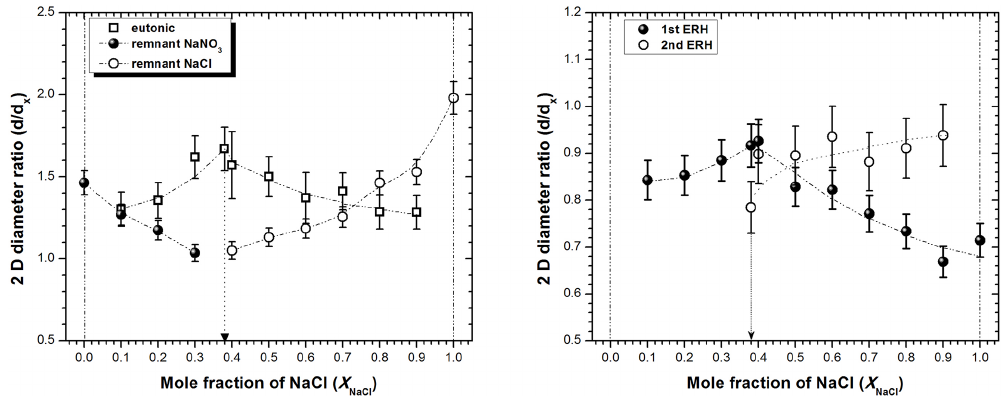
Figure 6. (a) 2-D diameter ratios ( d/d x ) of the particles/aerosols plotted as a function of the NaCl mole fractions ( X NaCl ) , which represent the size increase due to the mutual deliquescence of the eutonic part at MDRH (“ d ”) compared to that of the solid particle at the start of the first transition ( “ d x ”) (eutonic: open squares); and due to the complete deliquescence of the pure salts (in the figure, NaNO 3 : closed circles and NaCl: open circles) at their second DRHs (“ d ”) compared to that of the partially deliquesced particle at MDRH (“ d x ”) and (b) 2-D diameter ratios ( d/d x ) of droplets/aerosols plotted as a function of the NaCl mole fractions ( X NaCl ) , which represent the size decrease due to the efflorescence of NaCl (“ d ”) compared to that of the liquid droplets at the start of the first efflorescence (“ d x ”) (first ERH: closed circles); and due to the mutual efflorescence of the eutonic compositions (second ERH: open circles) (“ d ”) compared to that of the partially effloresced particles ( “ d x ”).